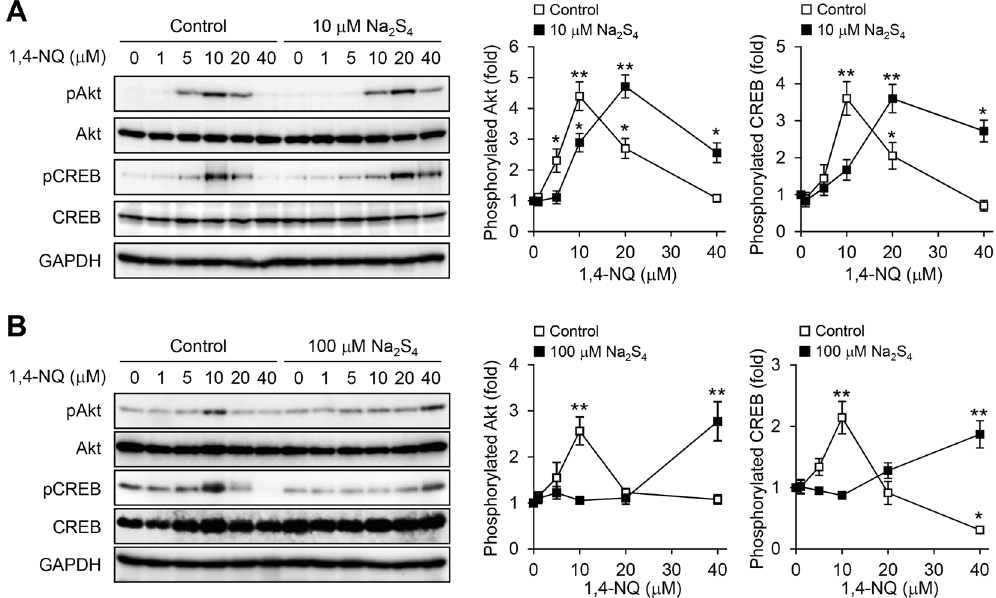
Figure 3. Participation of polysulfide in the 1,4-NQ-mediated phosphorylation of Akt and CREB in primary mouse hepatocytes. ( A ) Cells were exposed to the indicated concentrations of 1,4-NQ for 30 min in the presence of Na 2 S 4 at 0, 10 ( A ), or 100 ( B ) µ M. Akt and CREB phosphorylation was determined by western blotting (right). Representative blots are shown from three independent experiments. Band intensities were